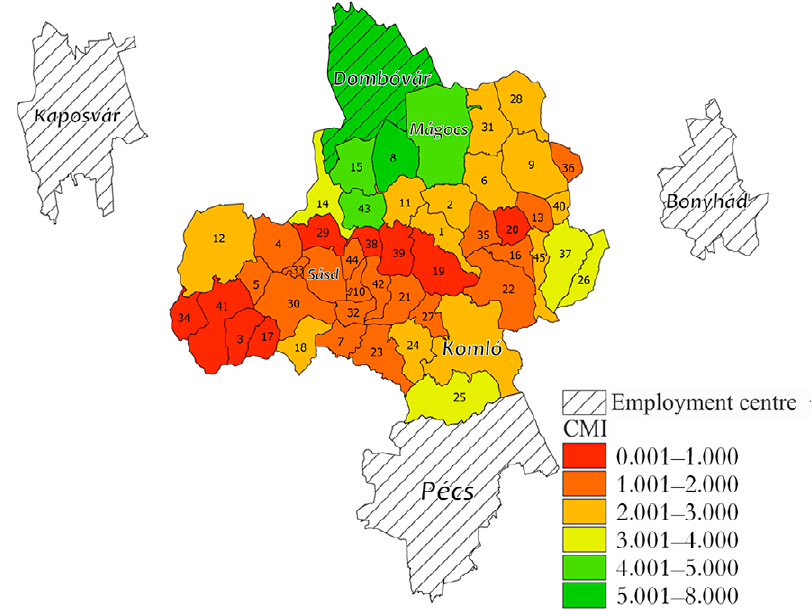
Figure 5. Modified CMI-values including transport subsidies (external